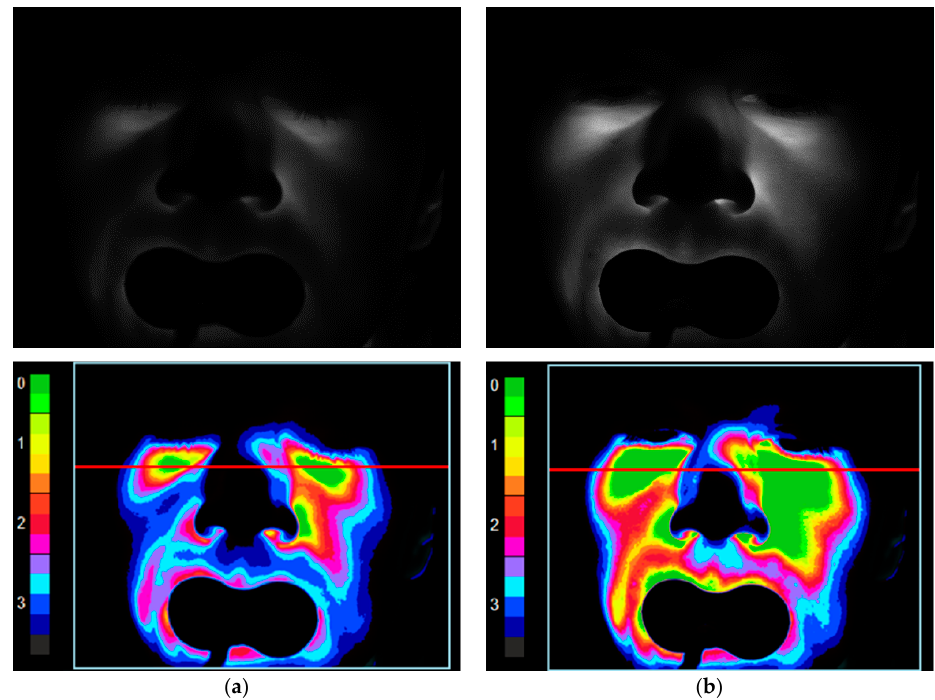
Figure 2. Registered ( top ) and processed ( bottom ) images for a conditionally healthy volunteer 1 (male) at a camera exposure time of 20.7 ms for probing radiation wavelengths of: 650 nm ( a ); and 850 nm ( b ). The red line is the selection of the area for analyzing the transmitted light.